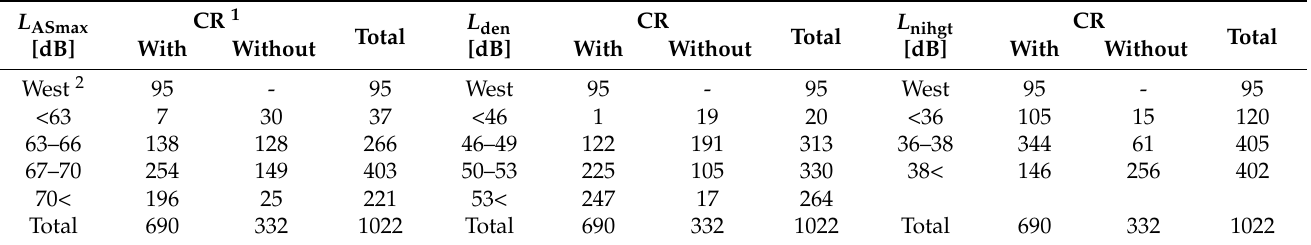
Table 3. Sample sizes divided by noise level.